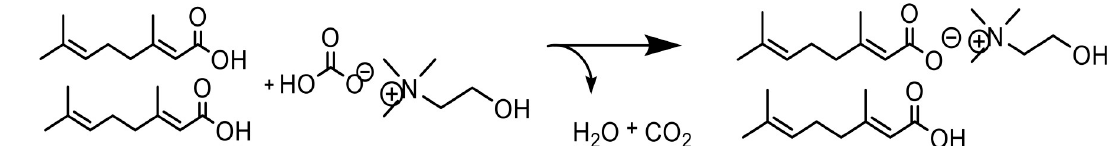
Fig 1. Synthesis of choline geranate. CAGE was synthesized with equimolar molar equivalents of cholinium cation, geranate anion, and protonated geranic acid from choline bicarbonate and geranic